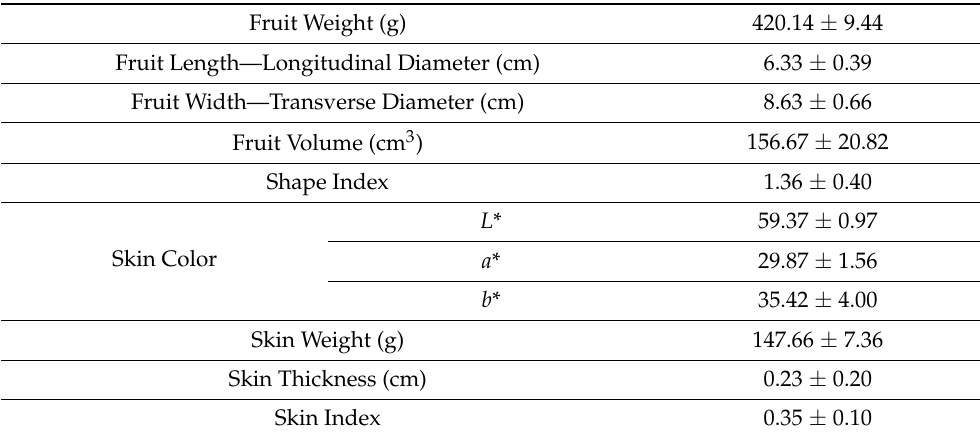
Table 1. Physical characteristics of the fruits of pomegranate from which the arils were extracted. Values are expressed as mean ± Standard Deviation (n = 10).